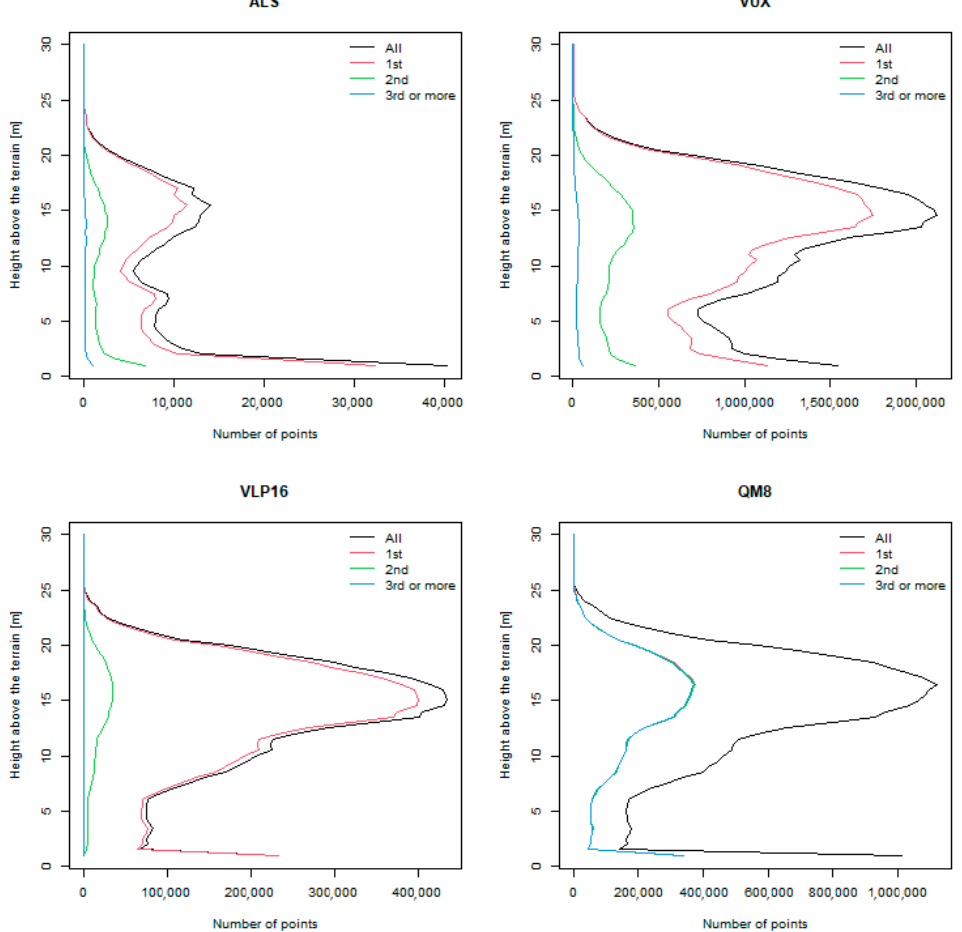
Figure 6. Frequency profiles showing the number of points per 0.5 m height above the terrain bins, for the entire 200 × 200 m study area. The black line shows the number of points including all returns, and the red, green, and blue lines show the first, second, and third or higher returns, respectively.